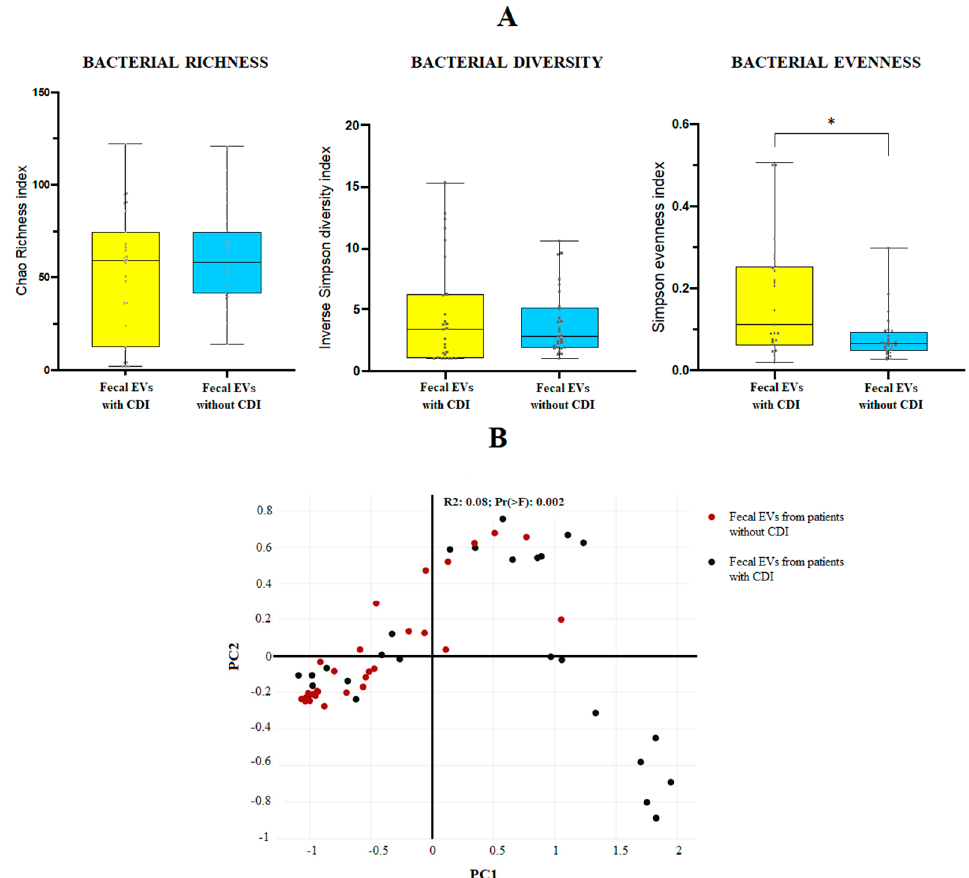
Figure 1. ( A ) Bacterial diversity (Inverse Simpson diversity index), bacterial evenness (Simpson evenness index) and bacterial richness (Chao1 richness index) expressed as the mean value with standard deviation for fecal EVs isolated from human feces of patients with and without C. difficile infection (CDI). * p < 0.05. Statistical differences are calculated according to Mann–Whitney test. ( B ) Sample distribution in function of the sample group using three-dimensional dynamic ordination. Beta-diversity analysis using a Bray–Curtis-based NMDS model of beta-diversity. Red circle: fecal EVs samples obtained from patients without CDI; black circle: fecal EVs samples obtained from patients with CDI.